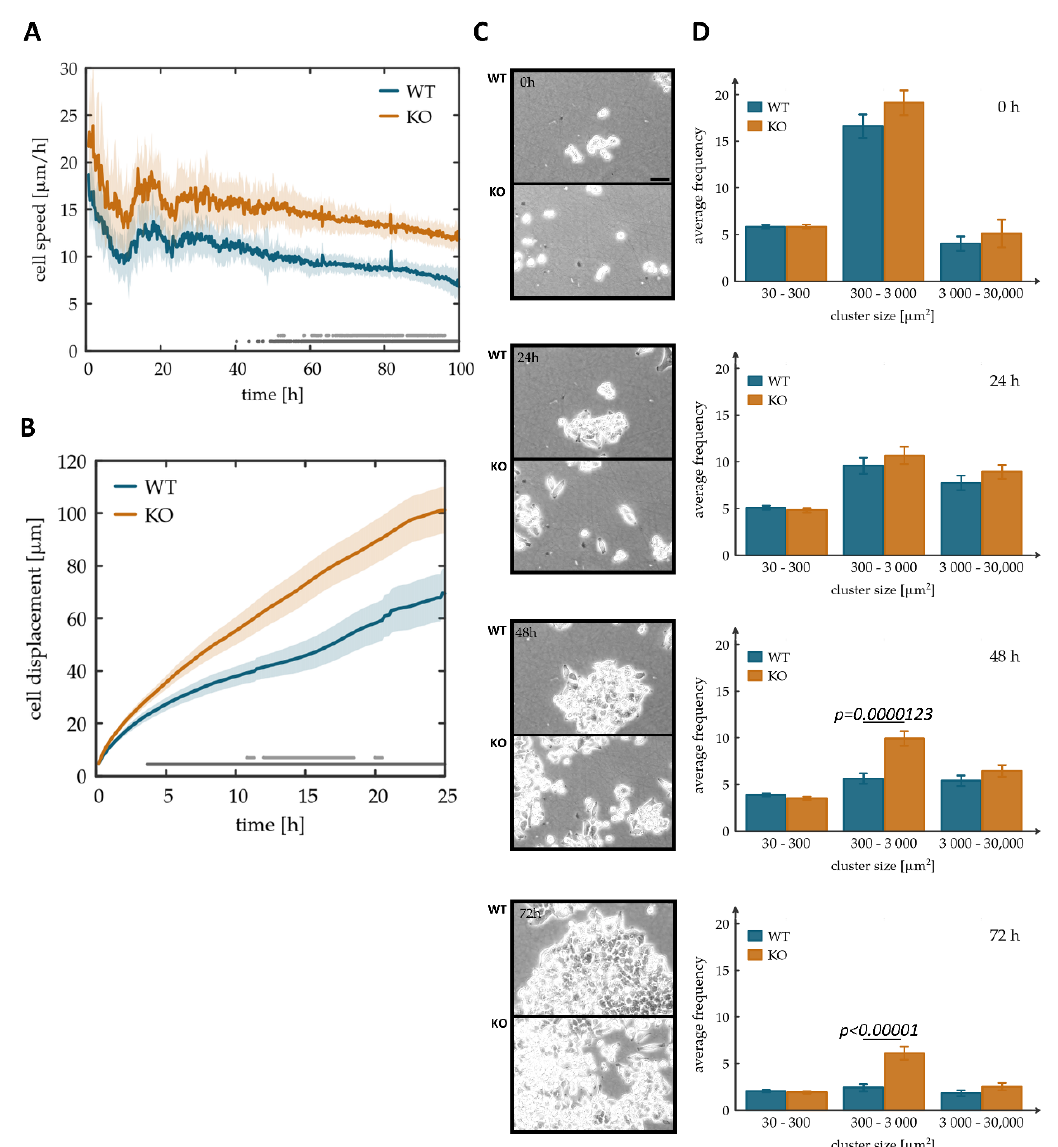
Figure 3. Tks4-KO cells display increased motility and less stable cell-cell adhesions. ( A ) Speed of two-dimensional random motility of WT and Tks4-KO (KO) cells in monolayer cultures, extracted by the optical flow (PIV) method. Solid lines indicate an average of 27 microscopic fields, shaded areas represent the SEM. The reported behavior was observed in n = 3 independent experiments. Statistically significant di ff erences between wild type and Tks4-KO cells are indicated at the bottom of the chart. Dark and light gray dots represent a p-value lower than 0.05 and 0.01, respectively, obtained by unpaired Student’s t-tests performed at each time point. ( B ) Net cell displacements during time intervals of various durations. Twenty wild type and Tks4-KO cells were followed manually over a period of 25 h post-seeding. Solid lines indicate the average while the shaded areas represent the SEM. The di ff erence between wild type and Tks4-KO cells is statistically significant for displacements larger than 20 µ m. Dark and light gray dots indicate p -values lower than 0.05 and 0.01, respectively, established by unpaired Student’s t-tests performed at each time point. ( C ) Representative micrographs of cell clusters, recorded at 0, 24, 48, 72 h post-theseeding. Scale bar represents 40 µ m. ( D ) Frequency of cell clusters categorized according to their area. Bar graphs display the average of three independent measurements, statistical analysis was carried out by using unpaired Student’s t-test, error bars show SEM.